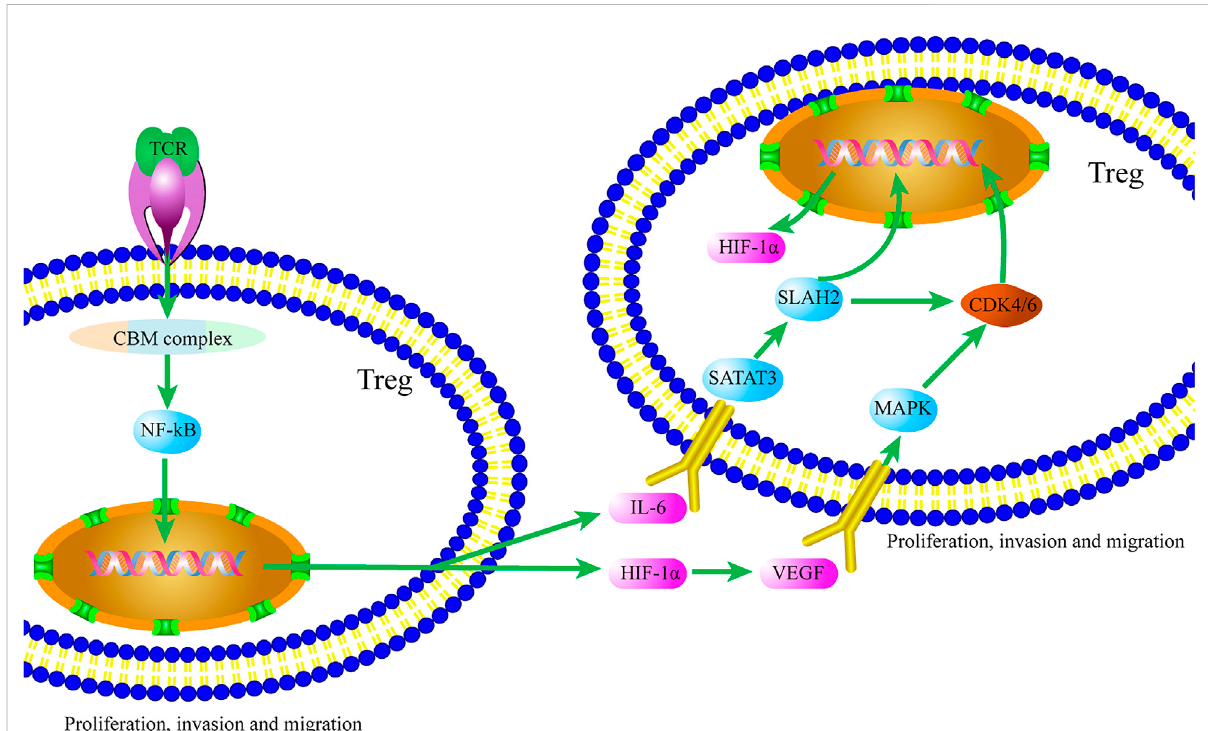
FIGURE 3 Crosstalk of the CBM complex/NF- κ B and MAPK/P27 signaling pathways Tregs contributes to the TME. Ligand binding to TCR of Tregs, HIF-1 α and IL-6 are produced via activating the CBM complex/NF- κ B signaling pathway. In turn, Treg proliferation and migration are promoted by HIF-1 α and IL-6 through the MAPK/CDK4/6/Rb and STAT3/SIAH2/P27 signaling pathways,